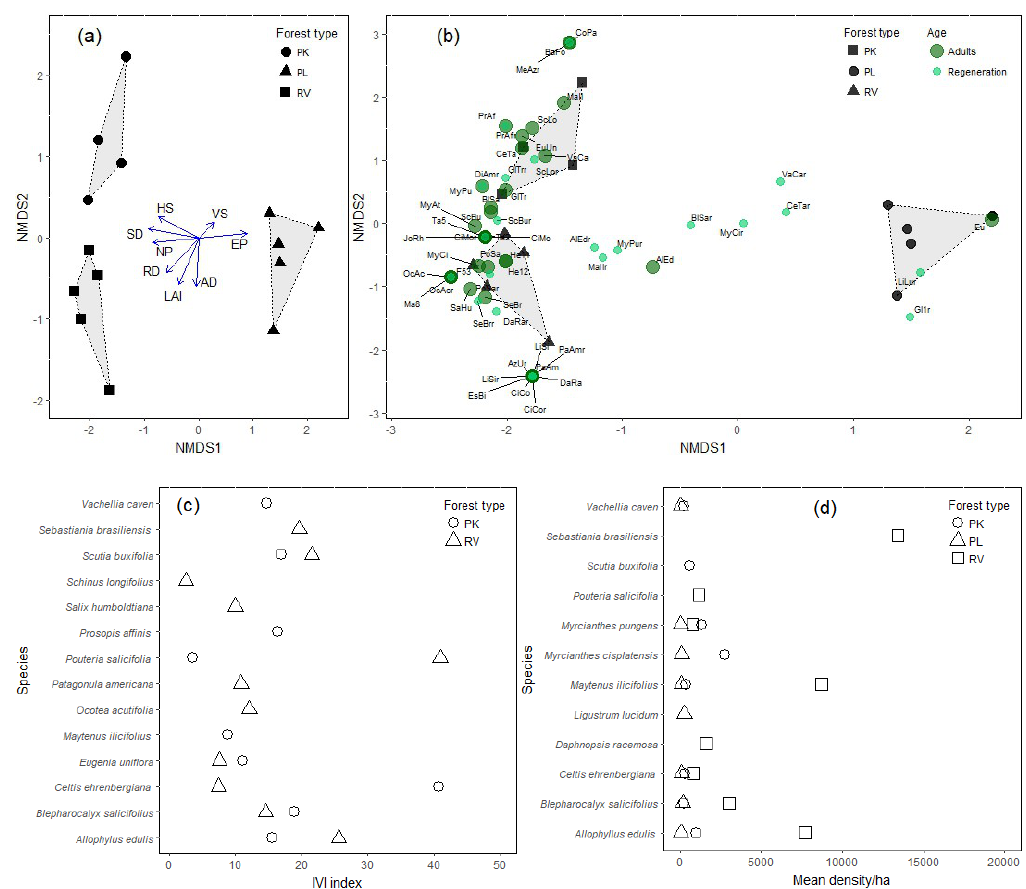
Figure 3. ( a ) Non-metric multidimensional scaling (NMDS) ordination of species from different forest types (PL: Eucalyptus plantations, RV: riverine forests, PK: park forests) and plots using the Bray–Curtis distance based on species abundance, showing distance between plots and eight explanatory variables: AD (Tree density), RD (Regeneration density), SD (Species diversity), HS (Horizontal structure diversity), VS (Vertical structure diversity), NP (Proportion of native richness as a proxy for naturalness), EP (Proportion of exotic species richness of all species as a proxy for non-nativeness), LAI (Leaf area index); ( b ) NMDS ordination of woody species showing distance between sites and tree species composition and regeneration species composition. Species were abbreviated, with the first four letters of the names and finishing in r for regeneration (e.g., AlEd: Allophyllus edulis AlEdr, respectively). Dashed lines show the convex hull within forest types; for species list and abbreviations, see Table 1, circle sizes correspond to the age category; ( c ) tree species with the highest mean IVI in native forests; ( d ) regeneration species with the highest mean density in the three forest types.